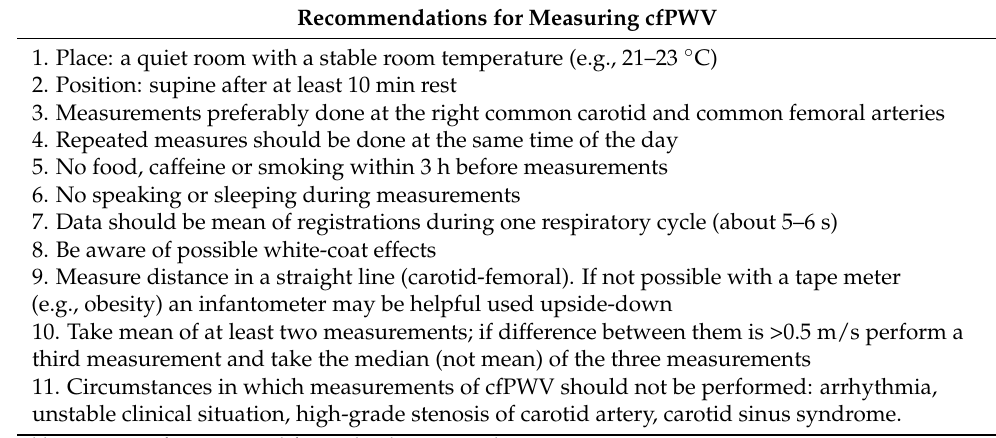
Table 1. Recommendations for measuring cfPWV in daily clinical practice [24,30].